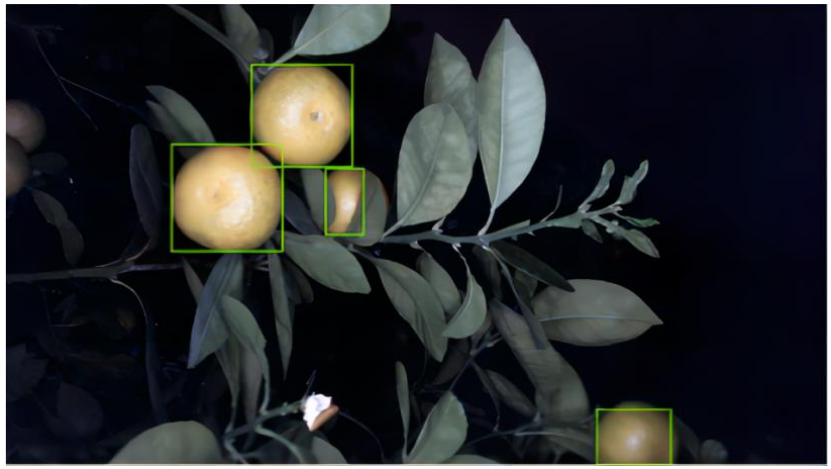
Figure 2. The citrus detection results with 55 – 65 Lx light intensity.